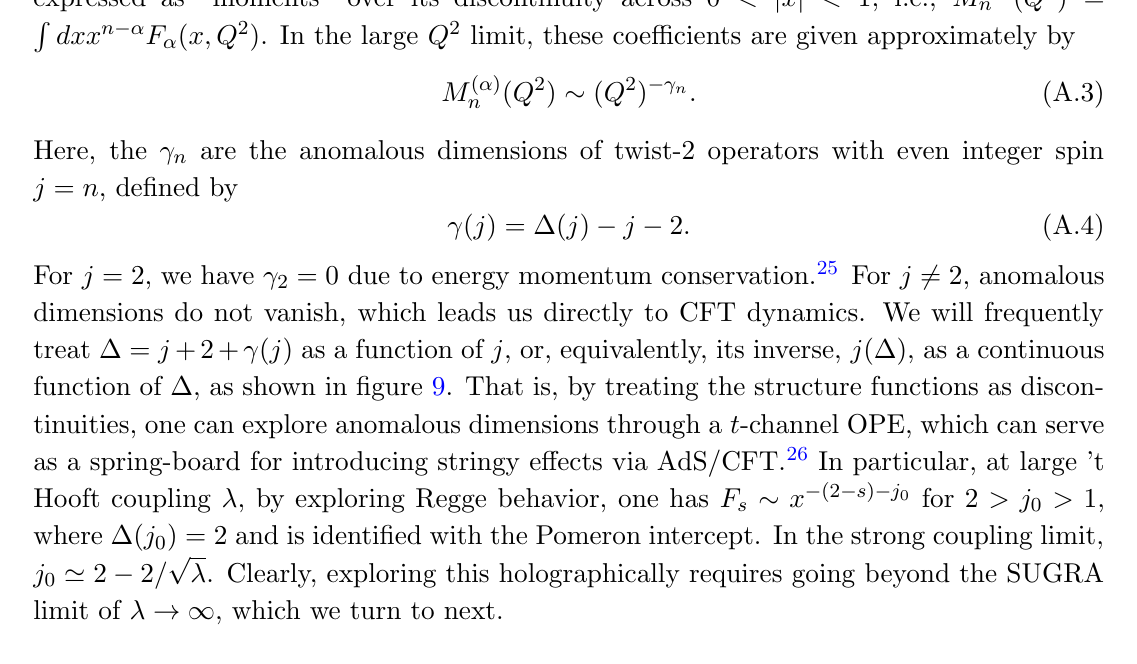
1), reproduced from ref. [15]. Symmetry about (cid:1) = 2 follows from conformal (cid:29)